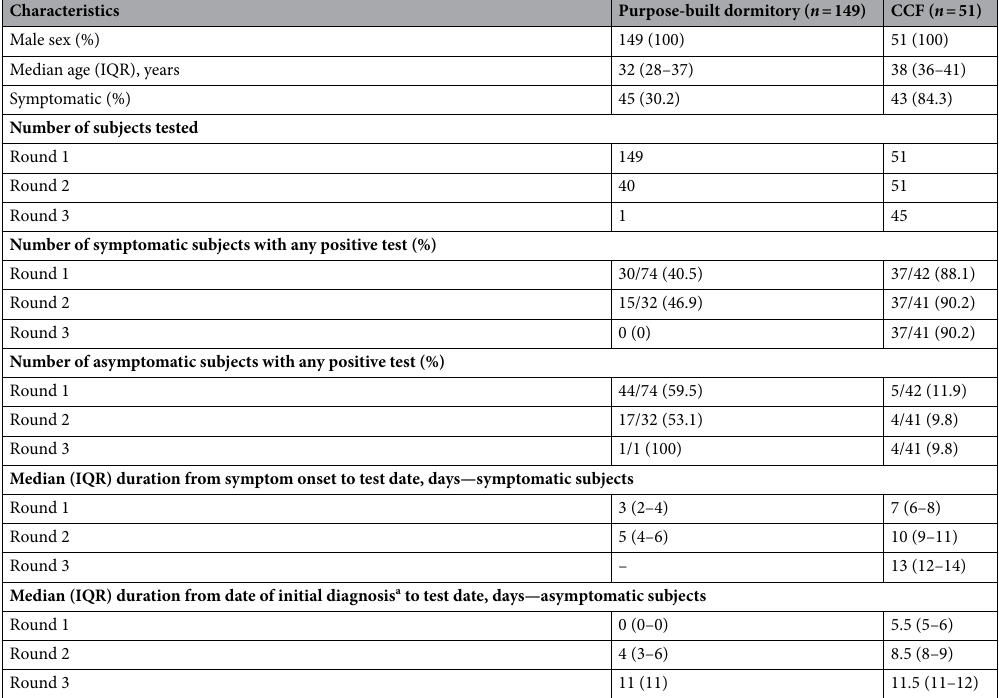
Table 1. Characteristics of recruited subjects. CCF community care facility, IQR interquartile range. a For asymptomatic subjects recruited at the purpose-built dormitory, all three samples (nasopharyngeal, self- administered nasal, and saliva) were taken at the same time during round 1. For asymptomatic subjects recruited at CCF, subjects were diagnosed with COVID-19 via prior RT-PCR testing and only two samples (self-administered nasal and saliva) were taken during round